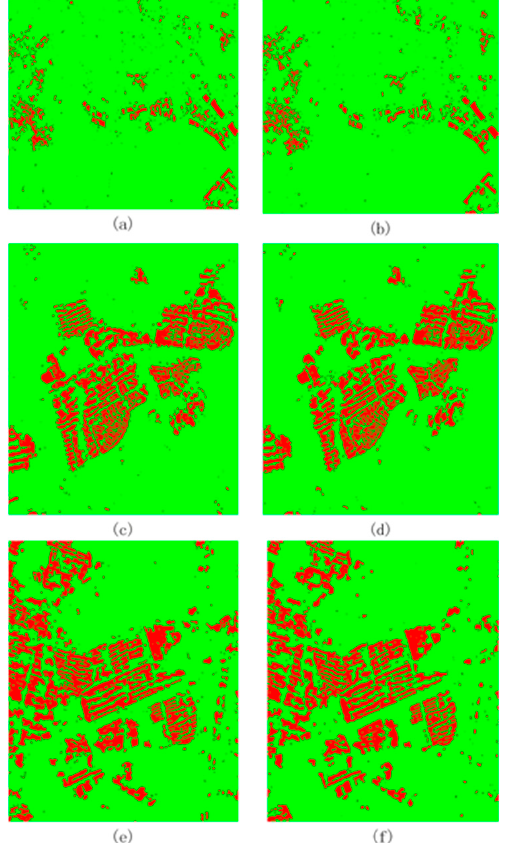
Figure 8. Comparison of feature sets under three data using G 0 texture parameters before and after comparison. ( a , b ) is the experimental result under ESAR data, ( c , d ) is the experimental result under GF-3 data, and ( e , f ) is the experimental result under RADASAT-2 data. Where ( a , c , e ) is the experimental result of the input of only PauliRGB and ( b , d , f ) is the experimental result of the input texture parameter of PauliRGB and G 0 .